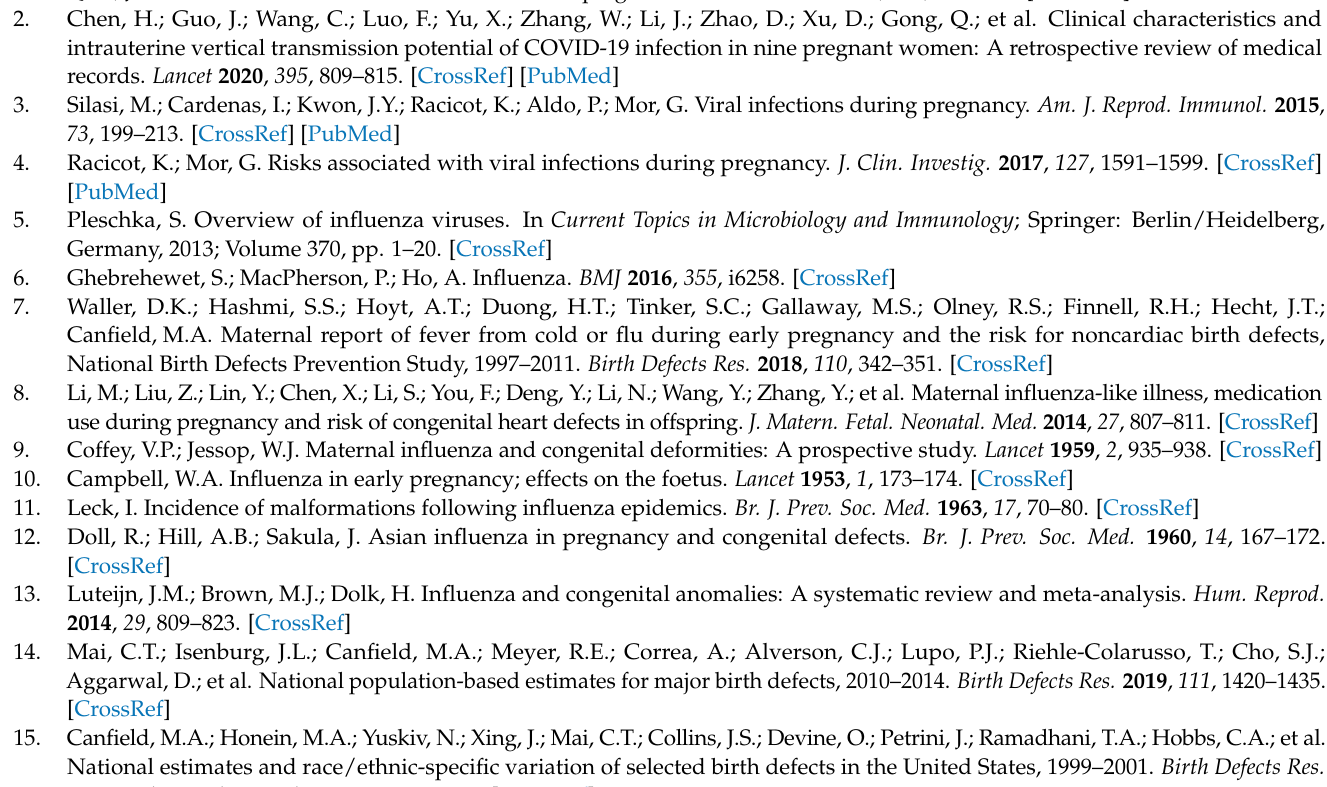
Figure S13. Risk of bias assessment at study and at domain level for eye anomalies. Figure S14. Risk of bias assessment at study and at domain level for limb reduction. Figure S15. Search key of the systematic search. Table S1. PRISMA 2020 checklist. Table S2. MOOSE Checklist for Meta-analyses of Observational Studies. Table S3. Table of included studies with outcomes. Table S4. The odds ratios for developing specific types of congenital malformations after first trimester. Table S5. Quality of